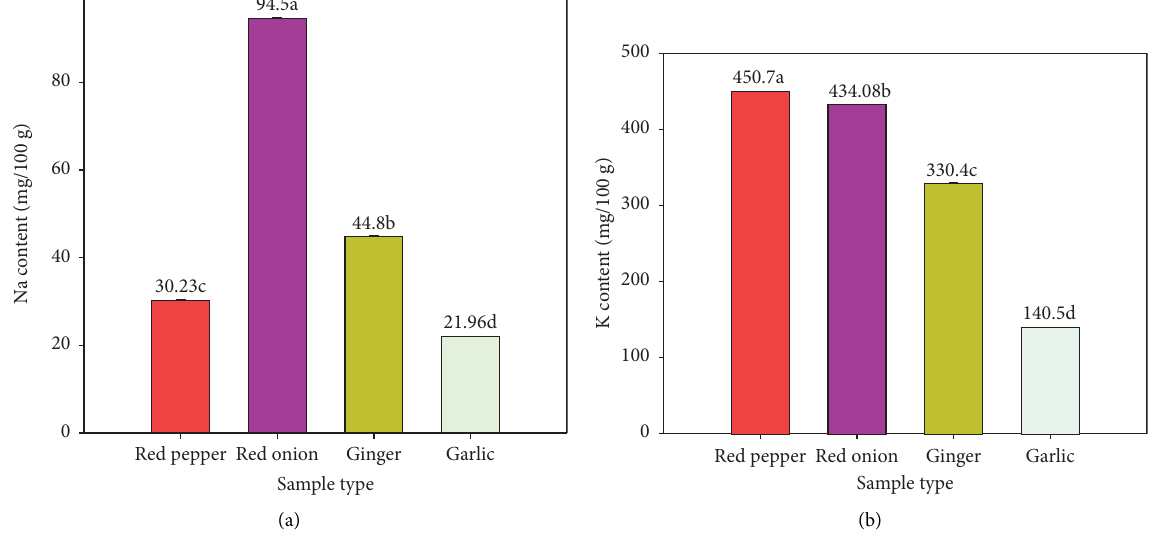
Figure 3: Sodium (a) and potassium (b) contents of red pepper, red onion, ginger, and